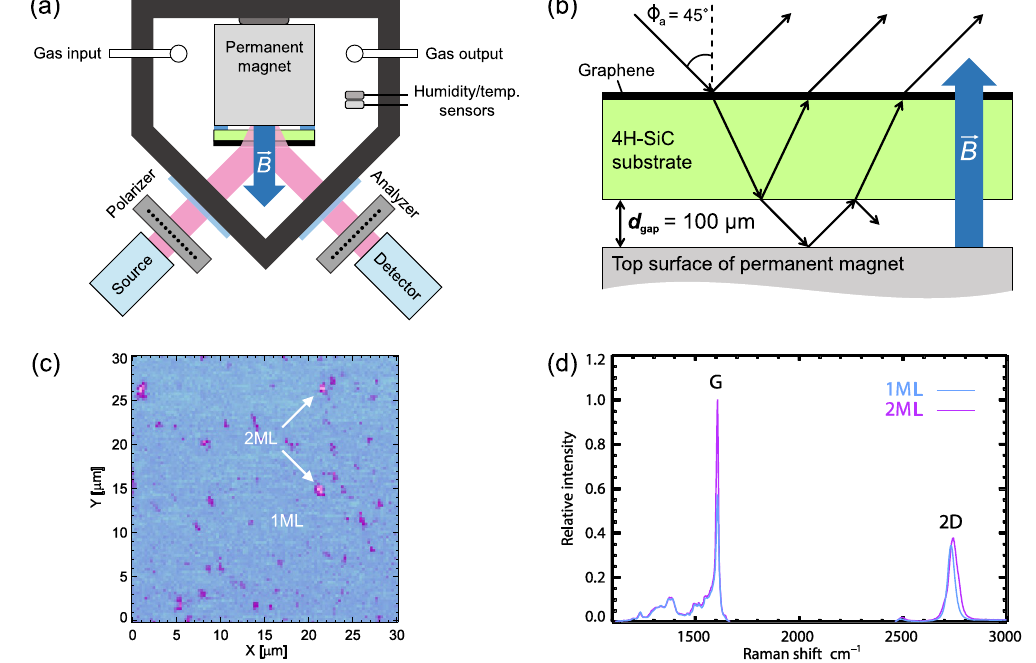
Figure 1. ( a ) Schematic of single-layer epitaxial graphene on SiC substrate located on top of a permanent magnet within a sealed gas chamber with optical ports for polarized THz radiation, and THz ellipsometer setup. ( b ) Schematic of the cavity-enhancement of the THz optical Hall effect using a resonant cavity between the sample and magnet surface. ( c ) Representative micro-reflectance map of the graphene surface. ( d ) Representative micro-Raman spectra of 1 ML and 2 ML sample